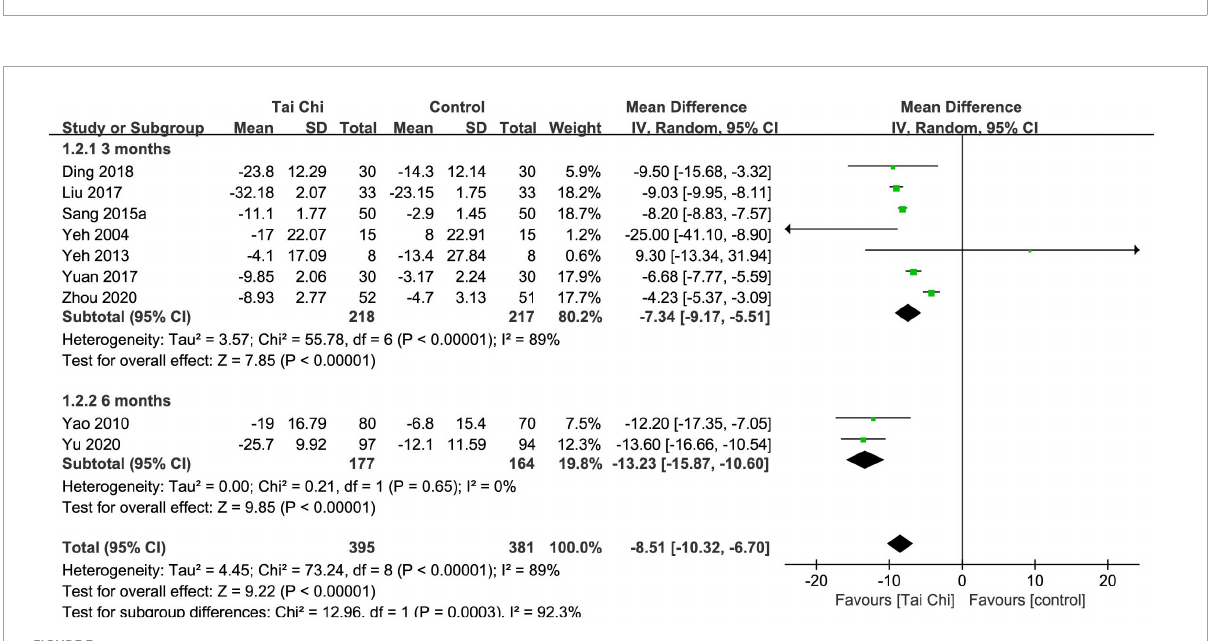
FIGURE2 Risk of bias summary (A) and bias graph (B) .